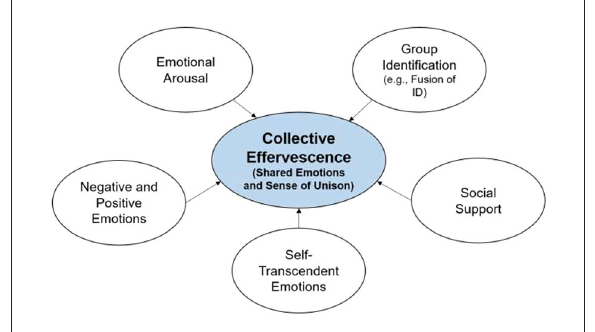
FIGURE2 Proximal outcomes-construct validity criteria of collective effervescence.